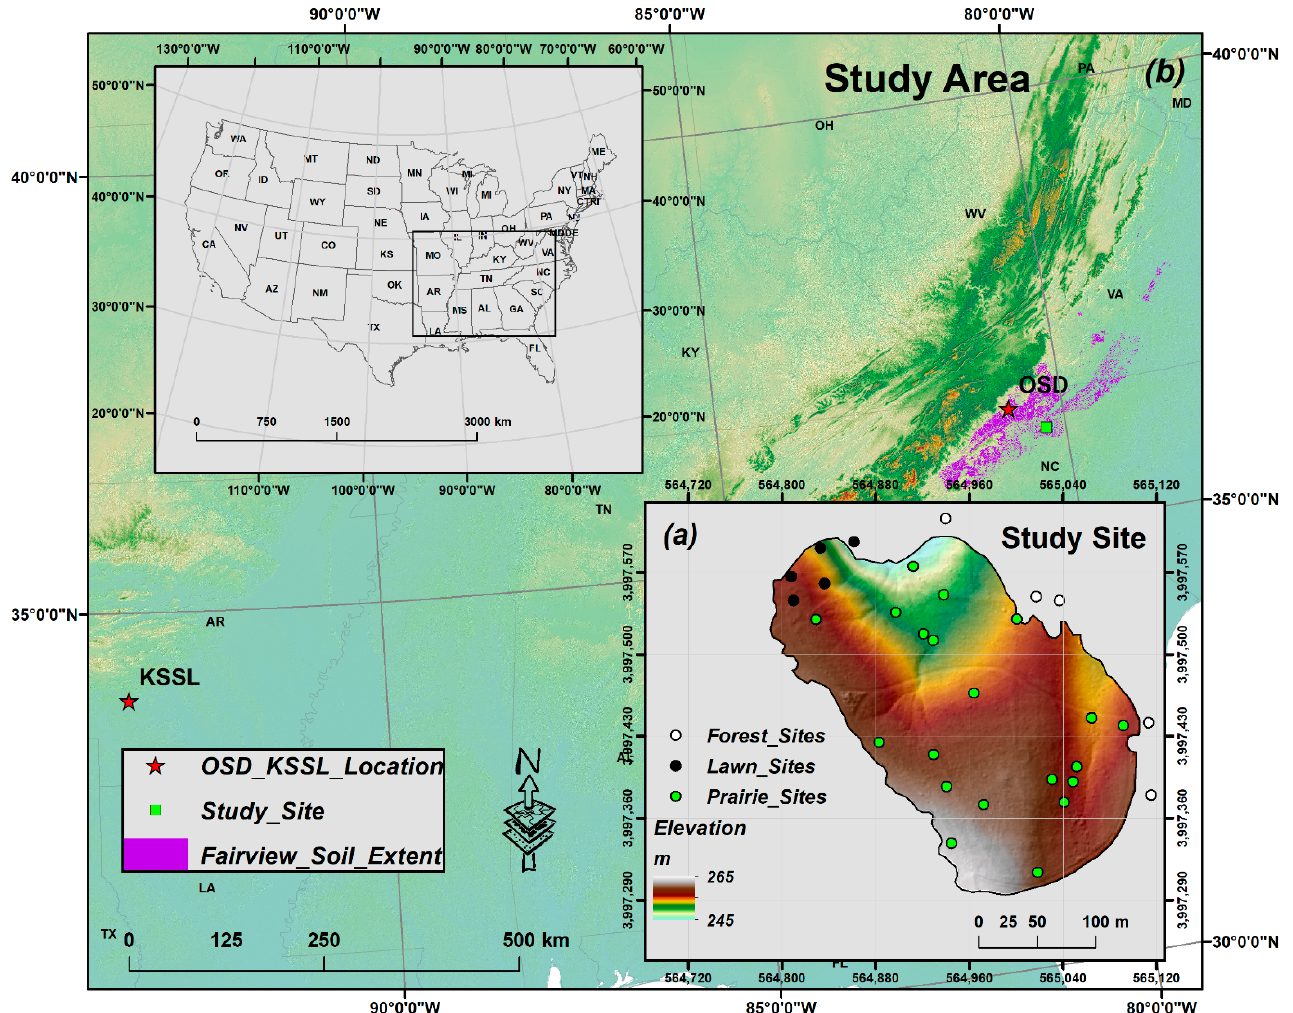
Figure 1. ( a ) Distribution of soil sampling points at the study site; ( b ) location of the study site and the spatial extent of the Fairview series in the study area showing the location of the official series description (OSD) and the pedon with laboratory analysis from the Kellogg Soil Survey Laboratory (KSSL).